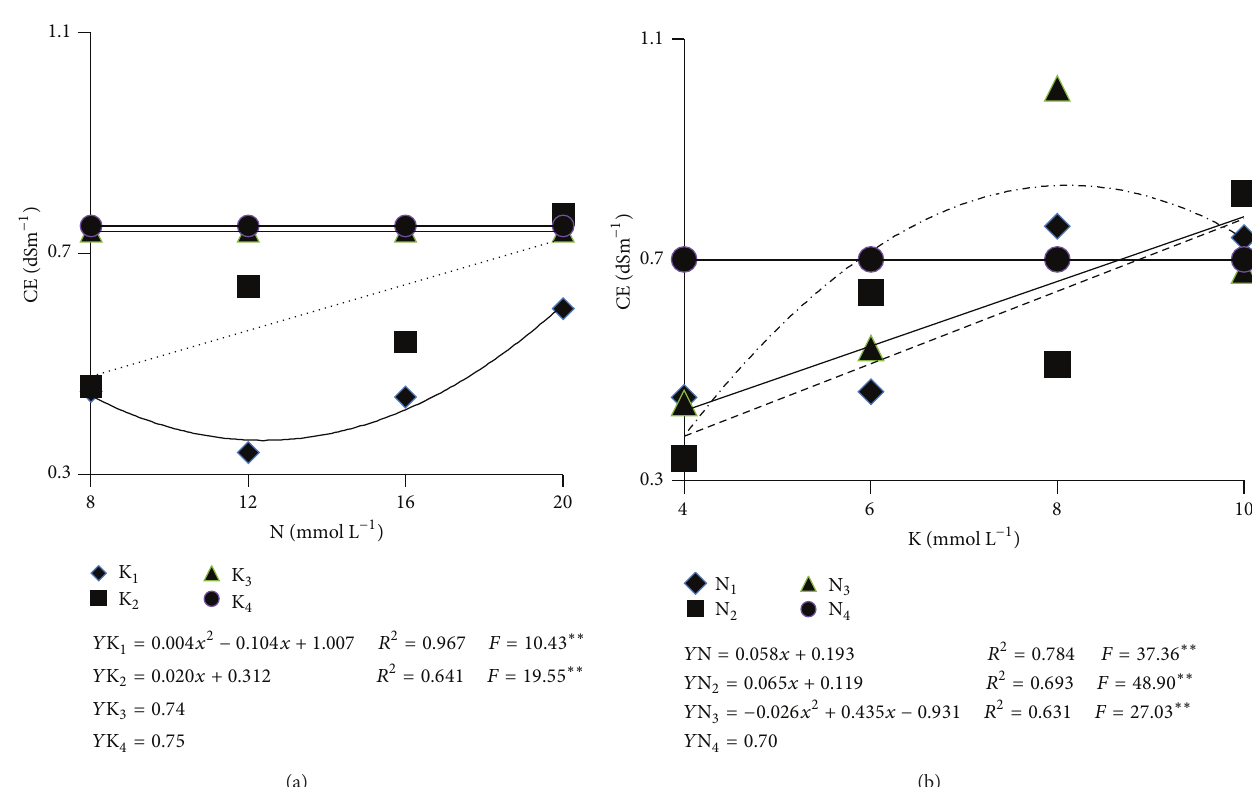
Figure 5: Electrical conductivity of the substratum solution extract (method 1:1.5v/v) 60 days after transplantation as influenced by the concentrations of N (a) and K (b) in the nutrients solution. ∗∗ : Significant at the level of 1%, according to the 𝐹 test.